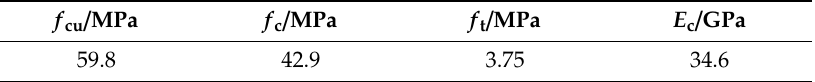
Table 1. Mechanical properties of high-strength concrete.